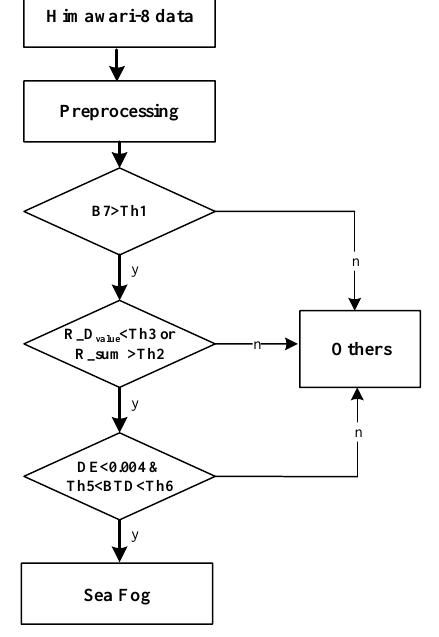
Figure 4. Flow chart of sea fog detection algorithm at dawn and dusk 4. RESULTS AND